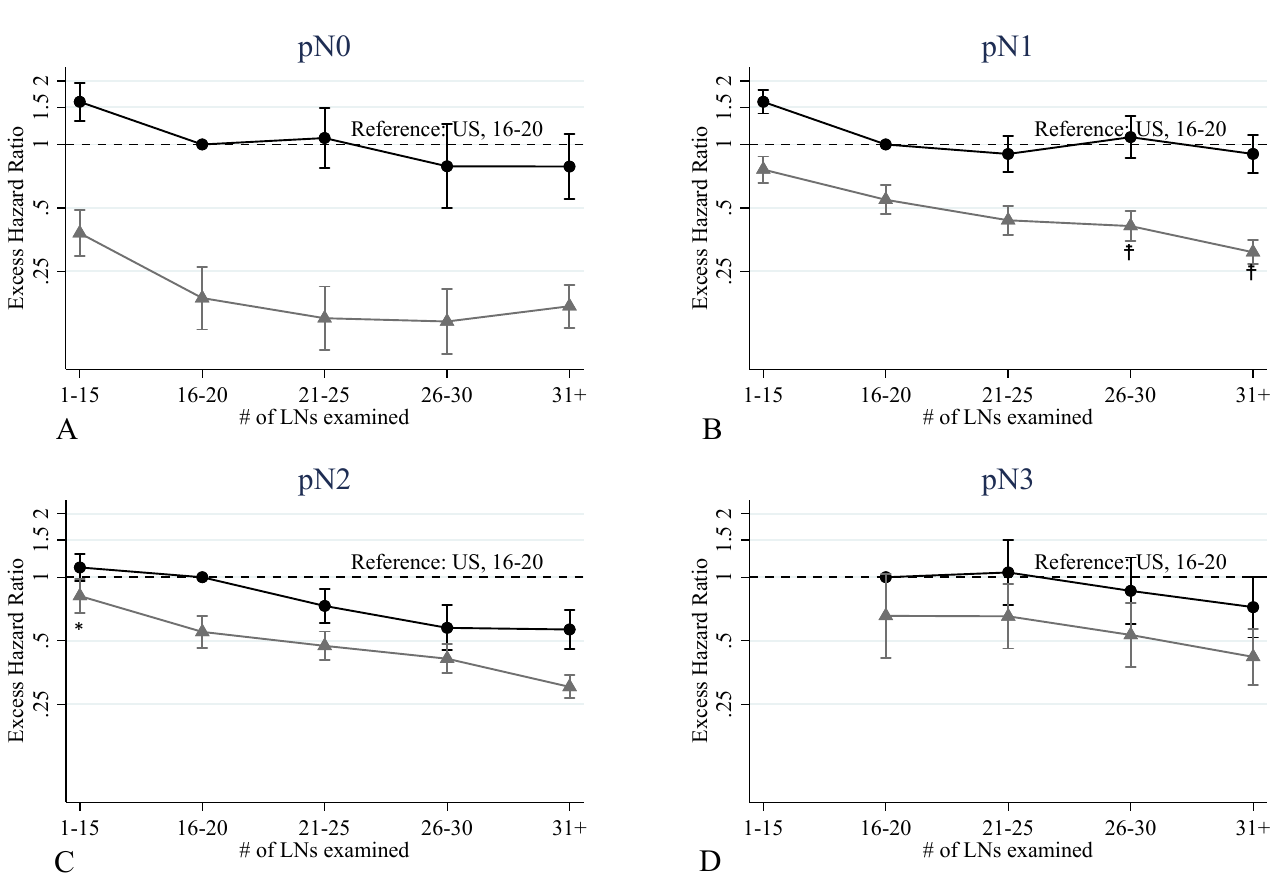
Figure 2. The excess hazard ratios of interaction between number of LN examined and country (Japan); Reference: United States and #LN examined 16 – 20, results from pathological N-classi fi cation speci fi c models, Black dots: United States and Gray triangles: Japan. is statistically signi fi cantly lower EHR of the interaction of Japan, and * is statistically signi fi cantly higher EHR of the interaction of Japan, Black and gray bar lines: 95% CI and statistical signi fi cance criterion is 5%. CI, con fi dence interval; EHR, excess hazard ratio; LN, lymph nodes.